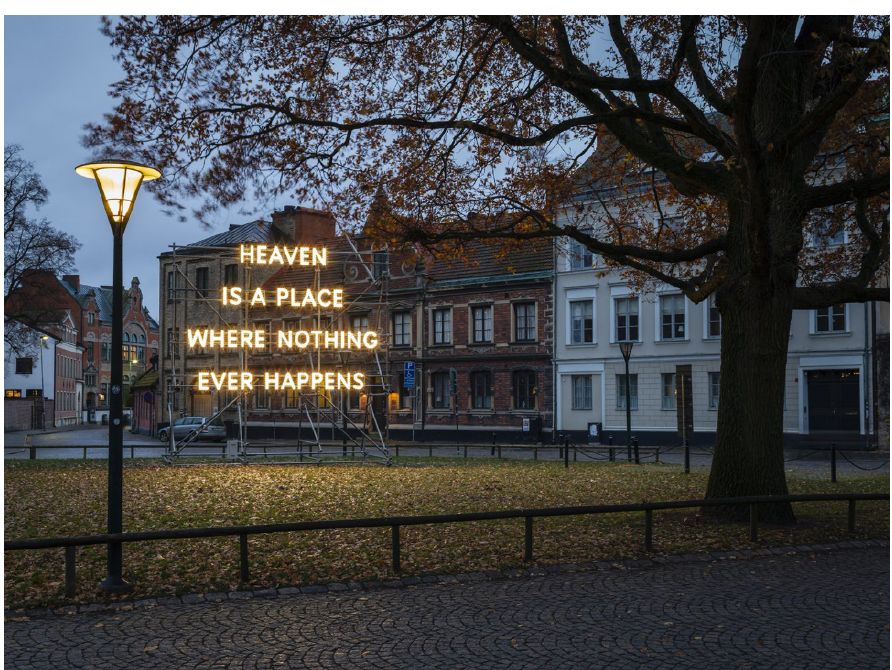
Figure 3. Heaven Is a Place Where Nothing Ever Happens, by Nathan Coley, Lund 2017–2018. Source: Peter Westrup.